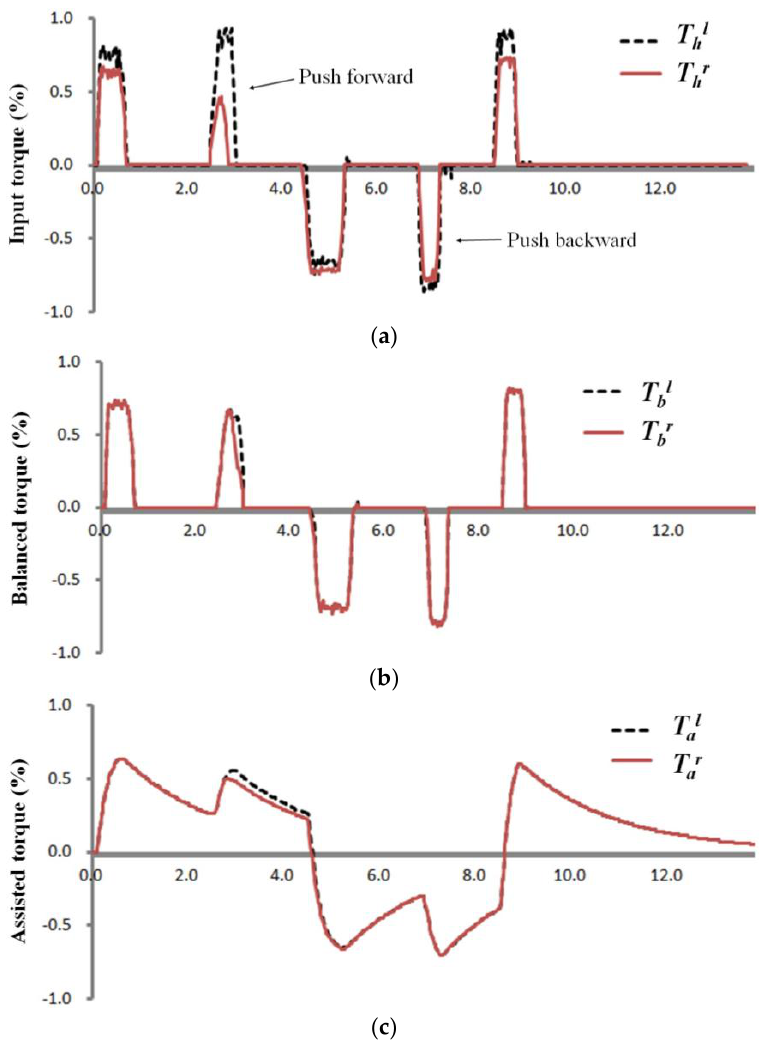
Figure 14. ( a ) Left and right input torque signals; ( b ) balanced torque signals; and ( c ) assist torque signals measured in HAPAW.